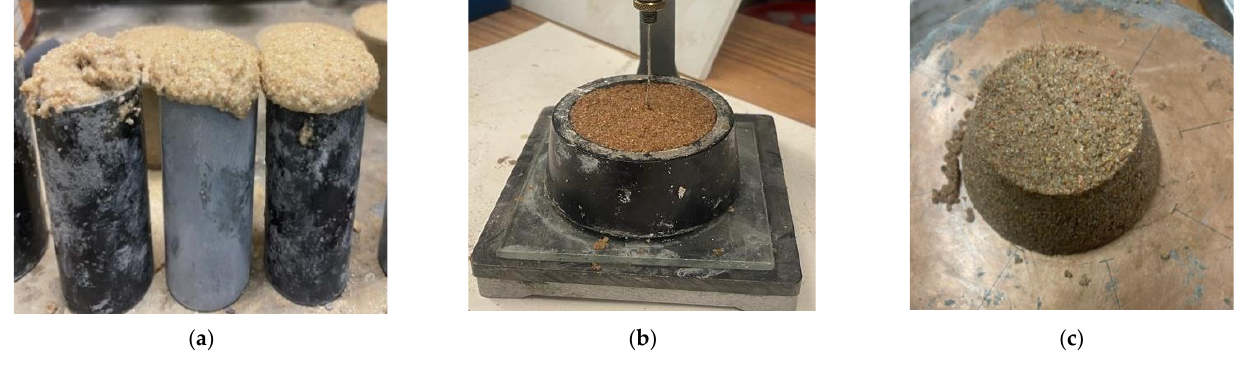
Figure 1. Challenges to producing bio-polymer concrete (BPC) identified through preliminary investigations showing; ( a ) foaming, ( b ) fast setting, and ( c ) zero flowability. It was suggested that when the mix acidity is increased, foam formation can be stopped due to the blockage of the active – NCO sites of polyisocyanate [2]. It was also shown that acids with the pK a in the range of 2.8–4.5 will retard rather than